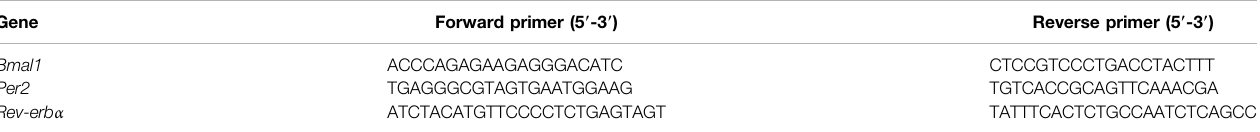
TABLE 2 | List of primers used for the puri fi cation of human promoters from human DNA.